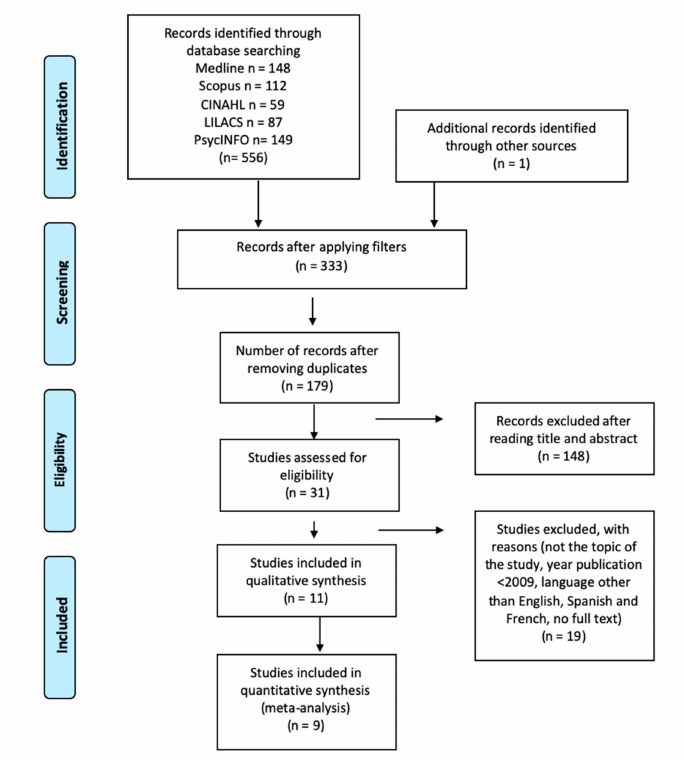
Figure 1. Flow diagram in the selection of articles according to Preferred Reporting Items for Systematic Reviews and Meta-analyses